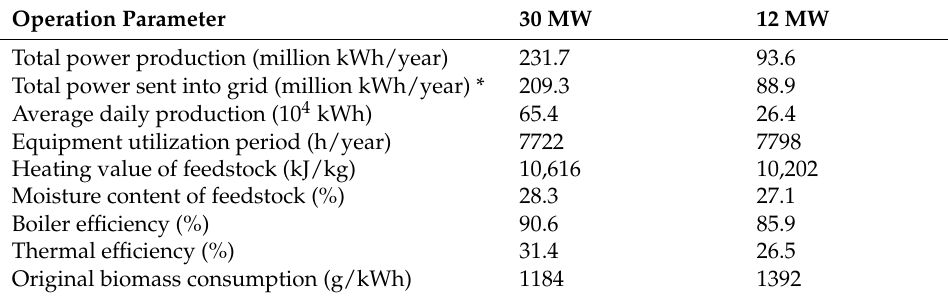
Table 2. Overall operation parameters in 2017.